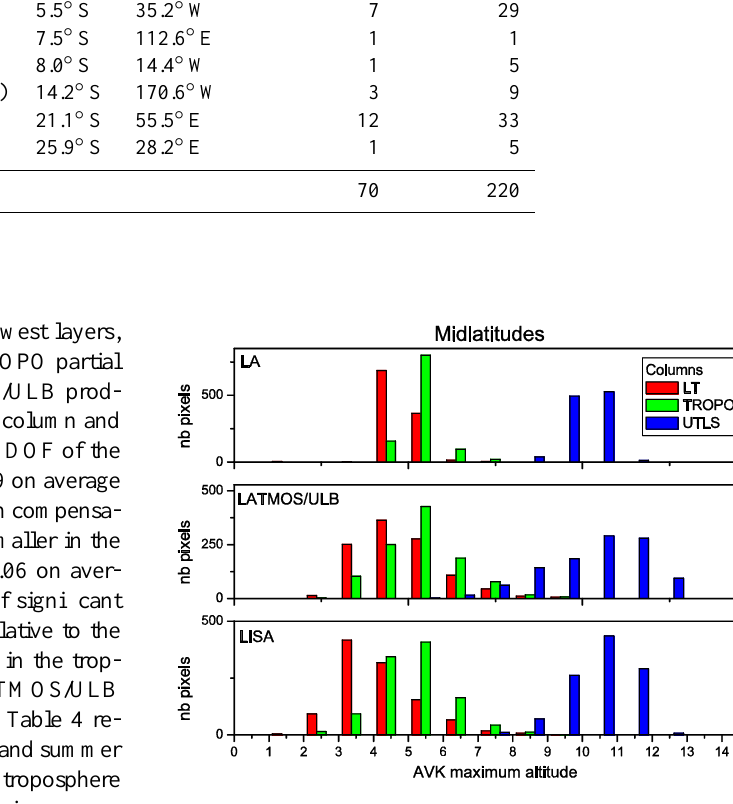
Fig. 2. Distribution of the altitude, in km, of the averaging kernels of the LT, TROPO and UTLS partial columns of ozone given over the set of pixels selected for the validation. The distribution for the LA, LATMOS/ULB and LISA products are presented in the top, middle and bottom panels,